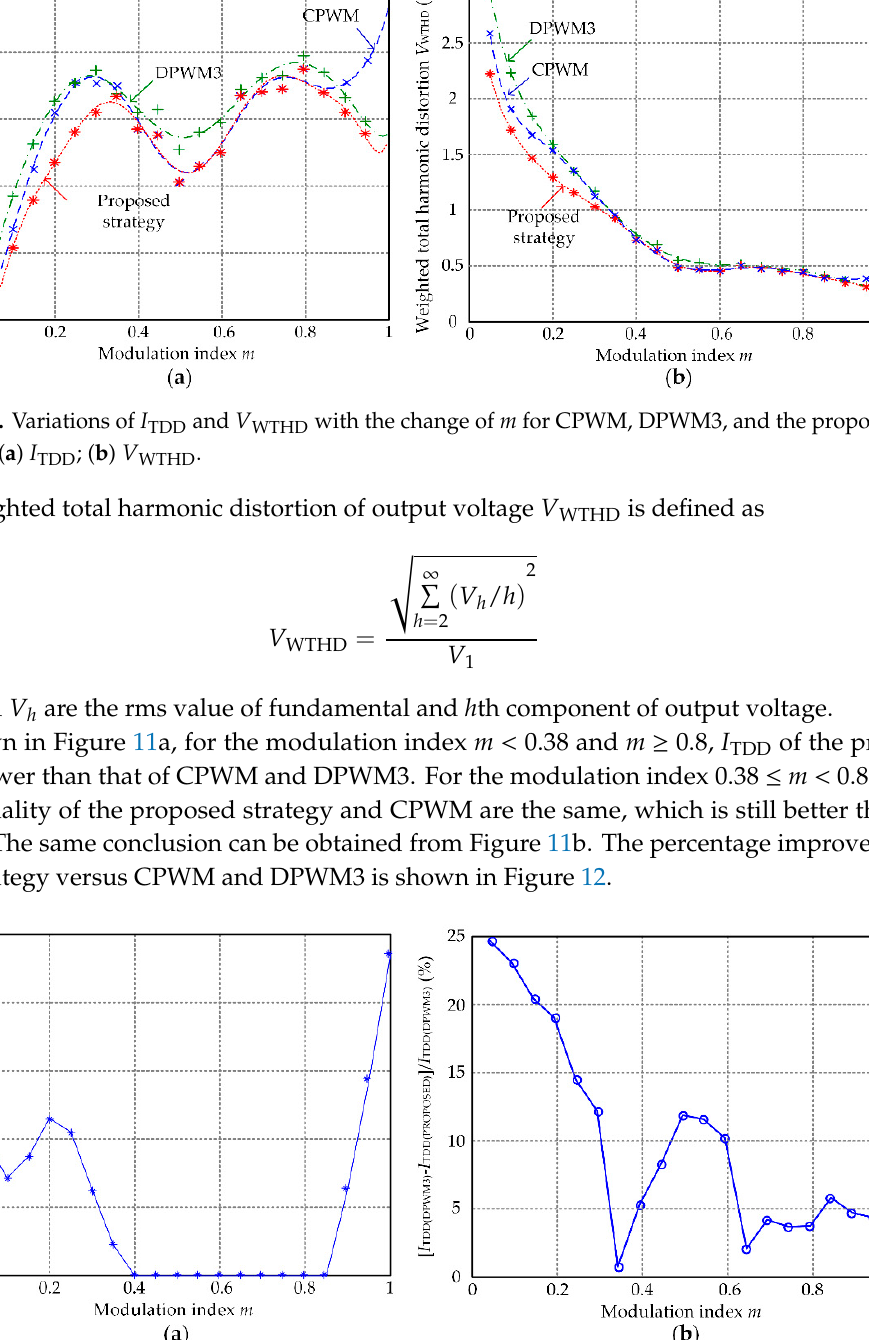
Figure 13. The dependence of neutral point voltage ripple v C1 - v C2 on m and φ :( a ) CPWM; ( b ) DPWM3; ( c ) proposed strategy. 6.2. Comparison of Power Losses The switching losses of CPWM, DPWM3 and proposed strategy are calculated according to the method in reference [23], and the dependence of switching loss on m and power factor angle φ are shown in Figure 14.